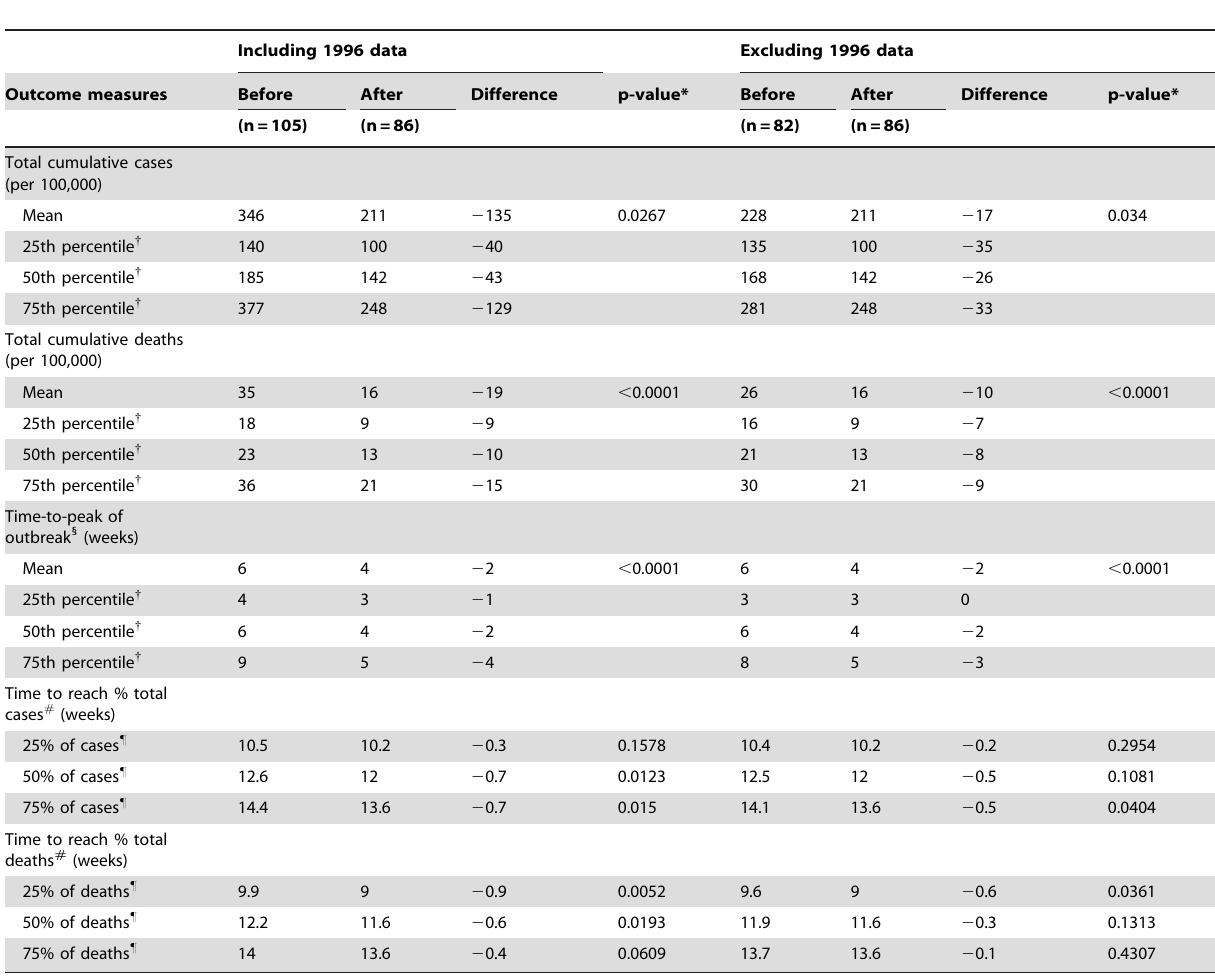
Table 1. Comparison before (1996–2002) and after (2003–2007) IDSR implementation: Total number of meningitis cases and deaths, time to peak of outbreak, and time to reach total cases and